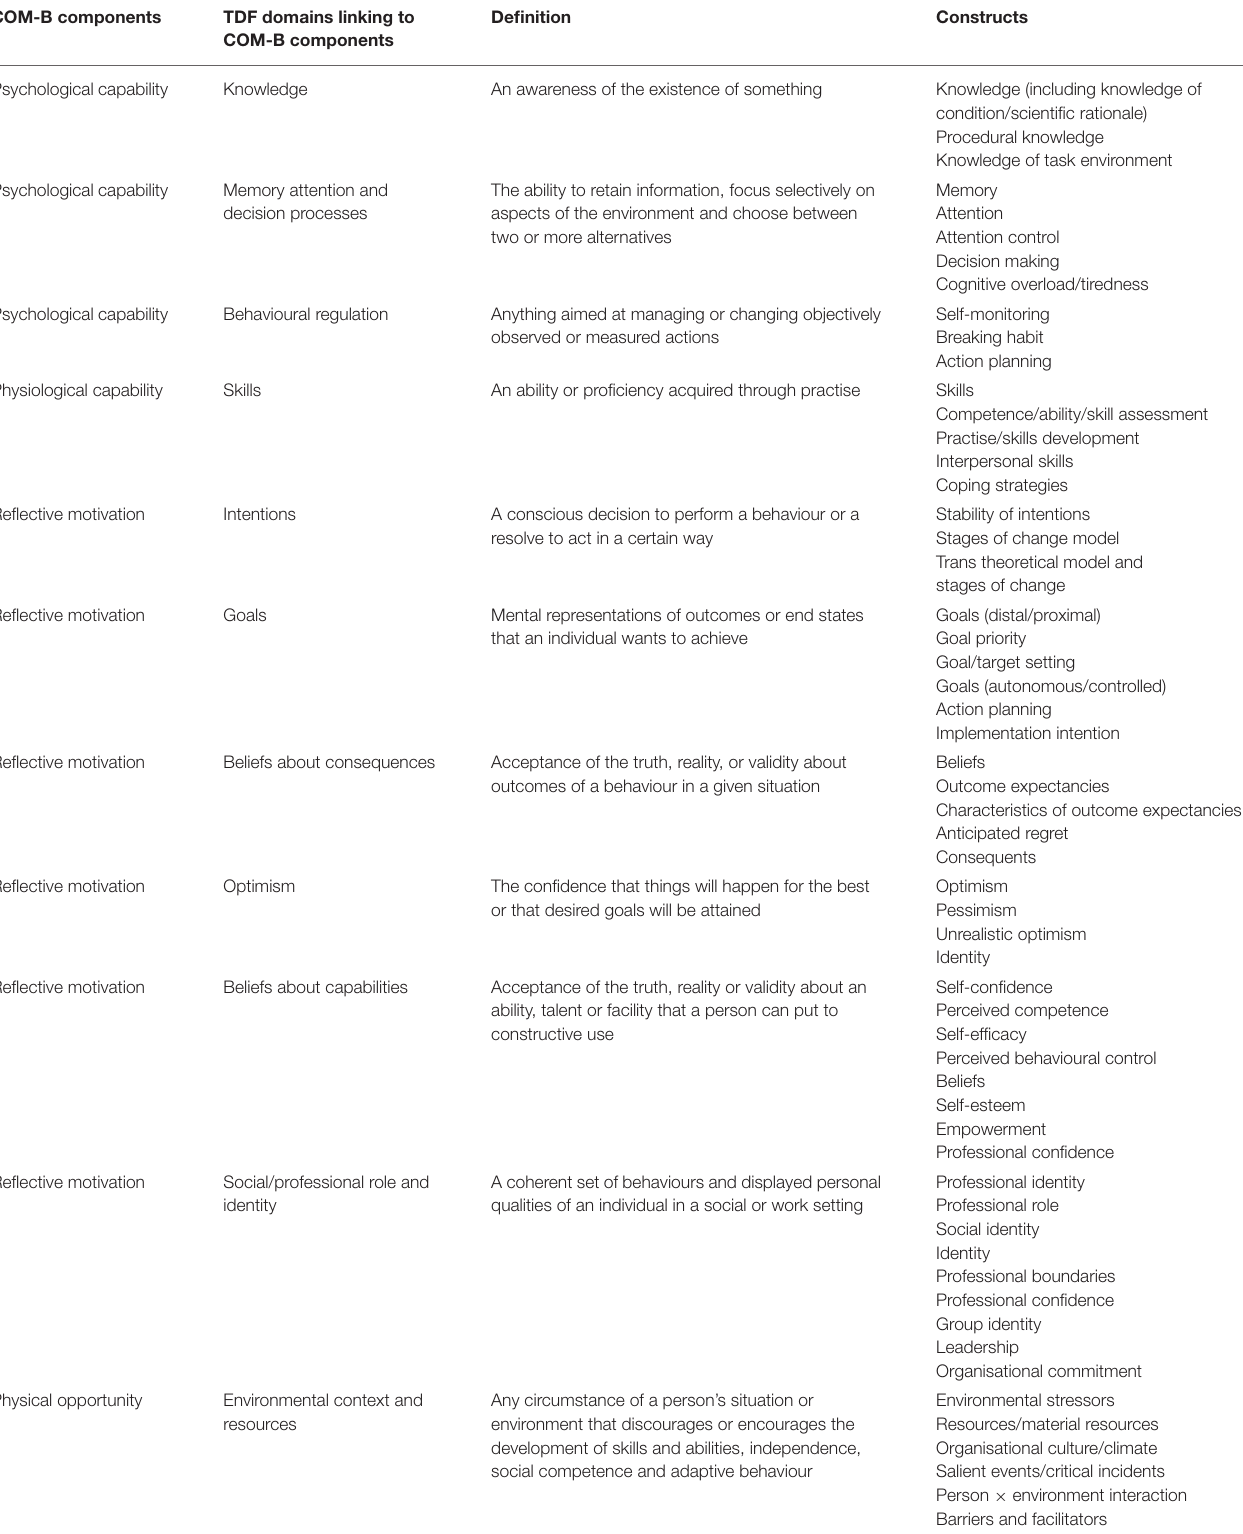
TABLE 1 | The Theoretical Domains Framework (v2) with definitions and component constructs Michie et al., 2014. COM-B